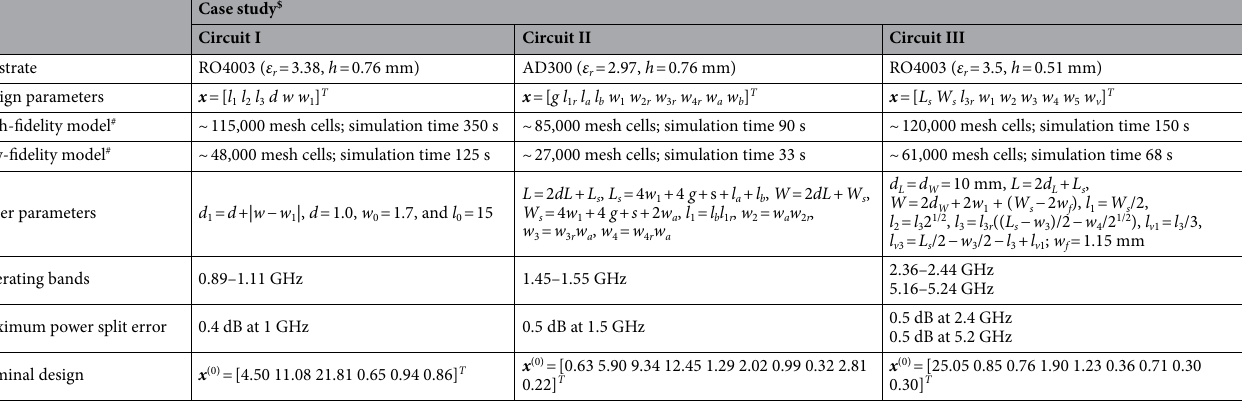
Table 1. Validation circuits. $ Parameters with subscript r are relative, and their deviations are recalculated accordingly in order to have the corresponding absolute parameters following the assumed probability distribution (here, Gaussian with variance of 0.017 mm). # All EM models are implemented in CST Microwave Studio and evaluated using the time domain solver.